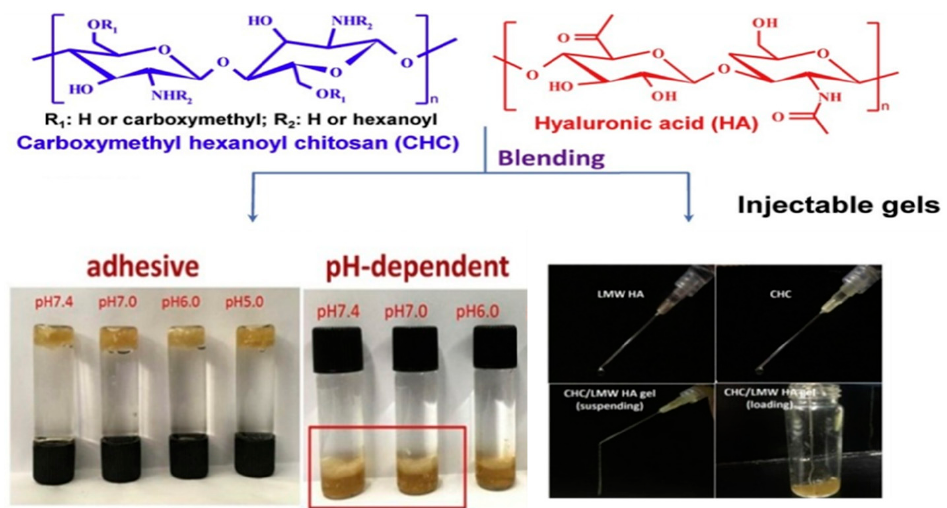
Figure 4. Preparation of CHC/HA IHs via hydrophobic interaction (adapted with permission from Lu et al., 2019).